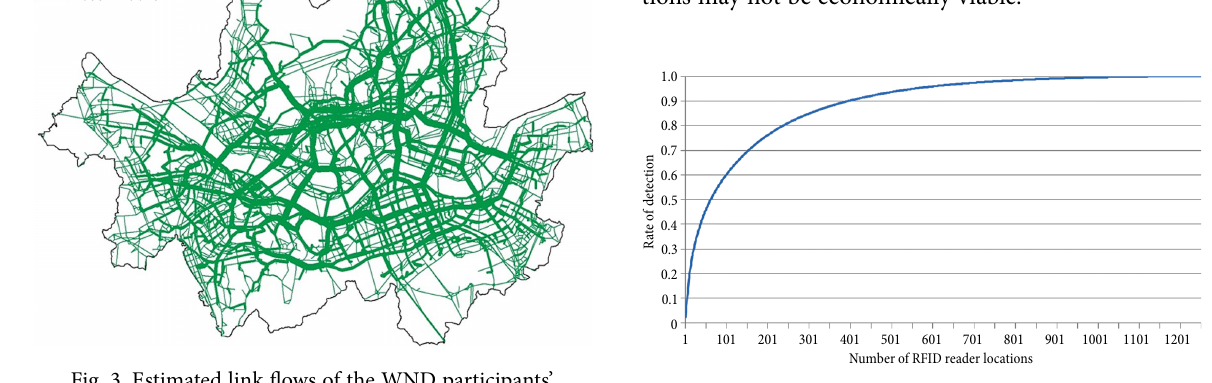
Fig. 5. Number of RFID readers and detection